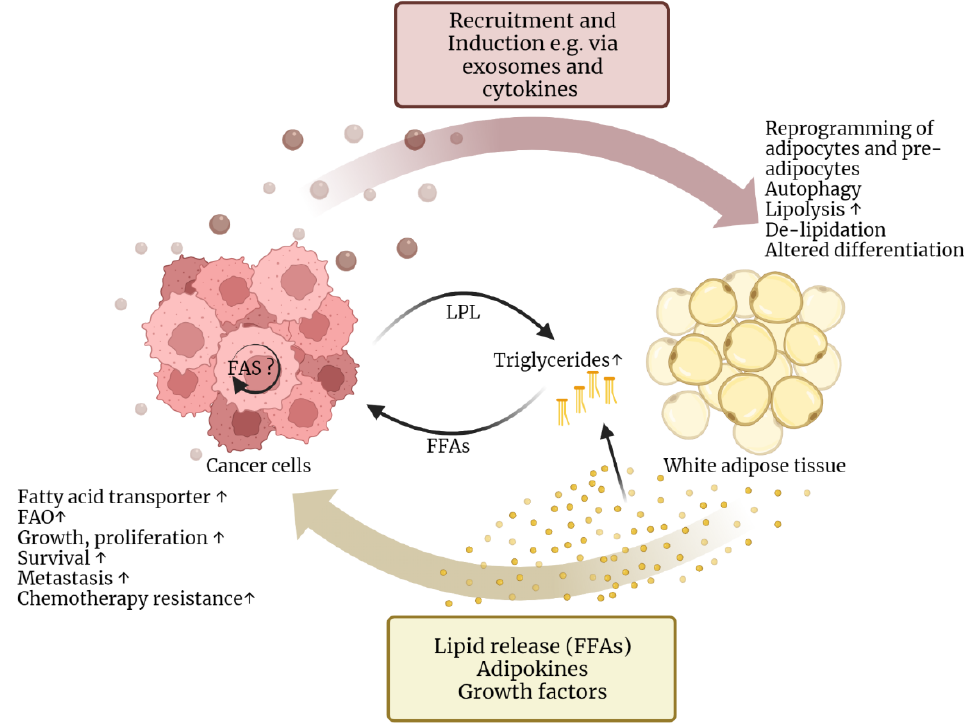
Figure 3. Reciprocal reprogramming of cancer cells and adipocytes. Adipocytes are part of the tumor microenvironment in multiple cancer entities. They can be induced and activated by tumor- derived factors, such as exosomes and cytokines. This results in the reprogramming of adipocytes and adipose stem cells, which includes autophagy, lipolysis, delipidation due to the release of free fatty acids (FFAs), de-differentiation of mature adipocytes and altered differentiation of adipose stem cells into senescent cancer-associated adipocytes. In addition to FFAs, adipocytes also secrete tumor-promoting adipokines and growth factors. FFAs can be directly taken up by the tumor cells or increase triglycerides (TGs) in the blood. These TGs can be hydrolyzed by tumor-derived LPL to FFAs, which then are taken up by tumor cells. In turn, uptake of FFAs from the microenvironment increases the expression of fatty acid transporters and FAO, stimulates growth and proliferation, increases survival, the ability for metastasis and resistance to chemotherapy. Cancer cells can also upregulate intrinsic fatty acid synthesis (FAS). However, newly synthesized FAs are not secreted and are rather used as substrates in anabolic processes and signaling.